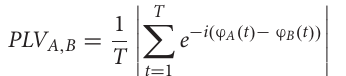
Electro-Gel (Electrode-Cap International, OH, United